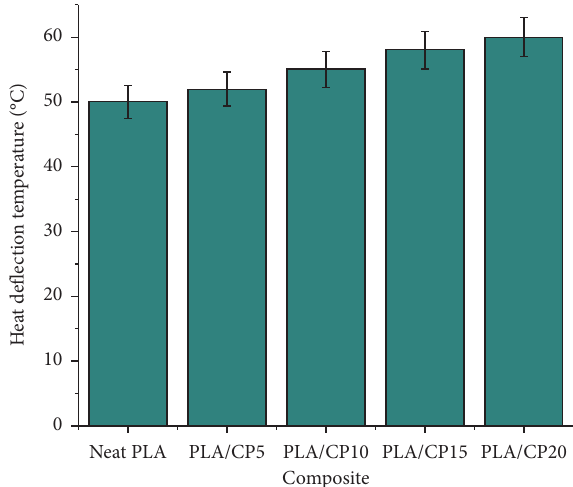
Figure 4: Melt flow index of PLA/CP.